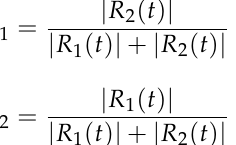
Timepoint Figure 12. Division of training set and prediction test set of CDI.